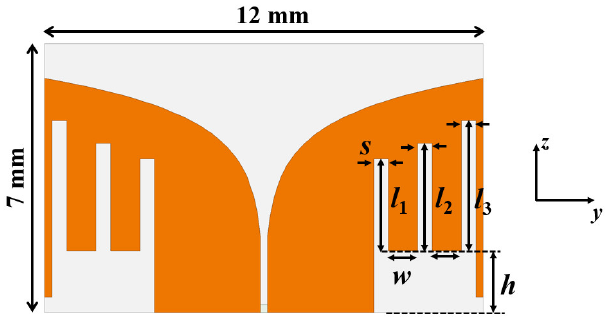
Figure 3. Geometry of the proposed Vivaldi antenna with vertical slots.